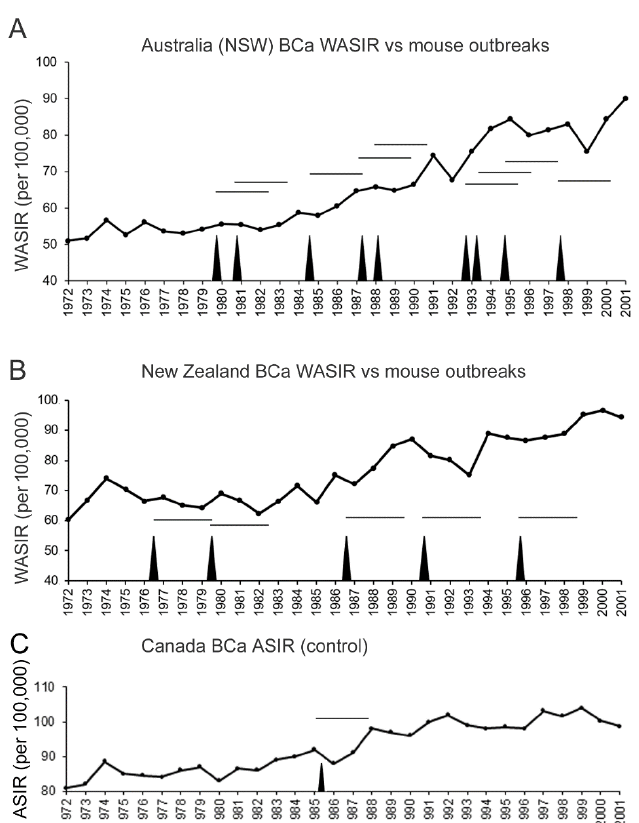
Figure 2. Mouse population outbreaks (black spikes) precede increases in breast cancer incidence by about 3–4 years in New South Wales (NSW), Australia ( A ) and New Zealand ( B ). World age-standardized incidence rate per 100,000 is plotted by year. Documented occurrence of mouse population outbreaks in NSW [31,32] and the Orongorongo Valley of Zealand [33] are indicated by vertical spikes. Horizontal lines show a 3-year span after an outbreak. ( C ) Canada age-standardized incidence rate per 100,000 (normalized to 1991 population) from 1972 to 2001 [2,40]. The sole vertical spike corresponds to a deer mouse population spike in the forests of Ontario [39].